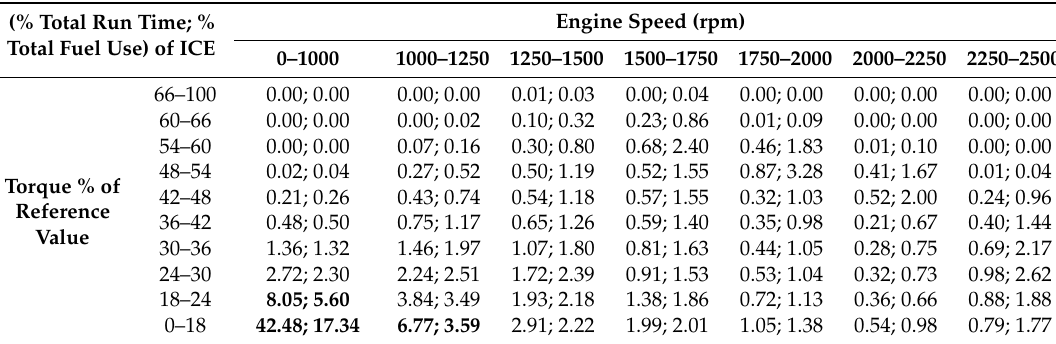
Table 1. Average engine run time/fuel use against speed-torque range of a telescopic